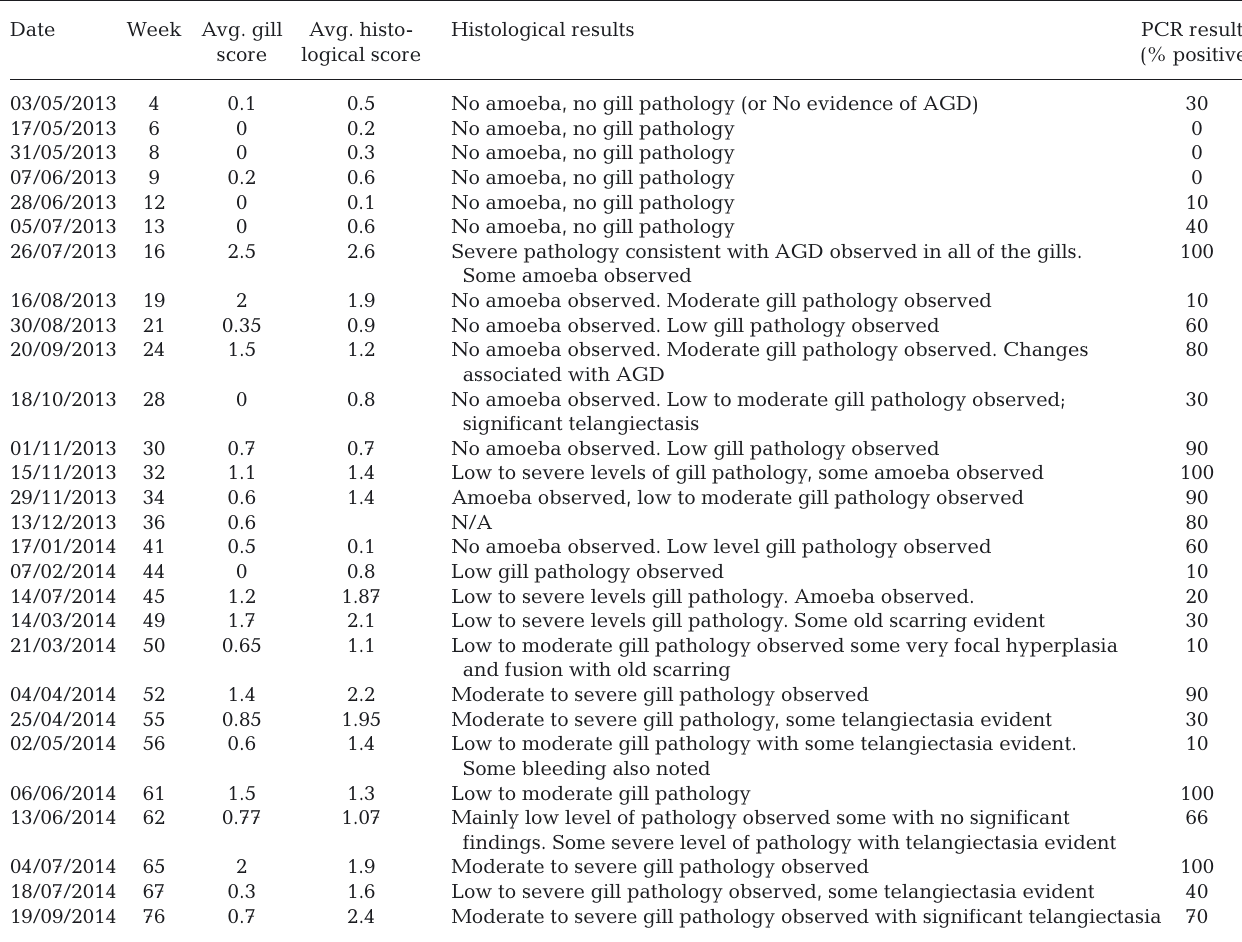
Table 4. Average gill score, average histological score (with comments) and % PCR-positive Atlantic salmon throughout the marine production cycle during the longitudinal study. Dates given as dd/mm/yyyy. N/A: not